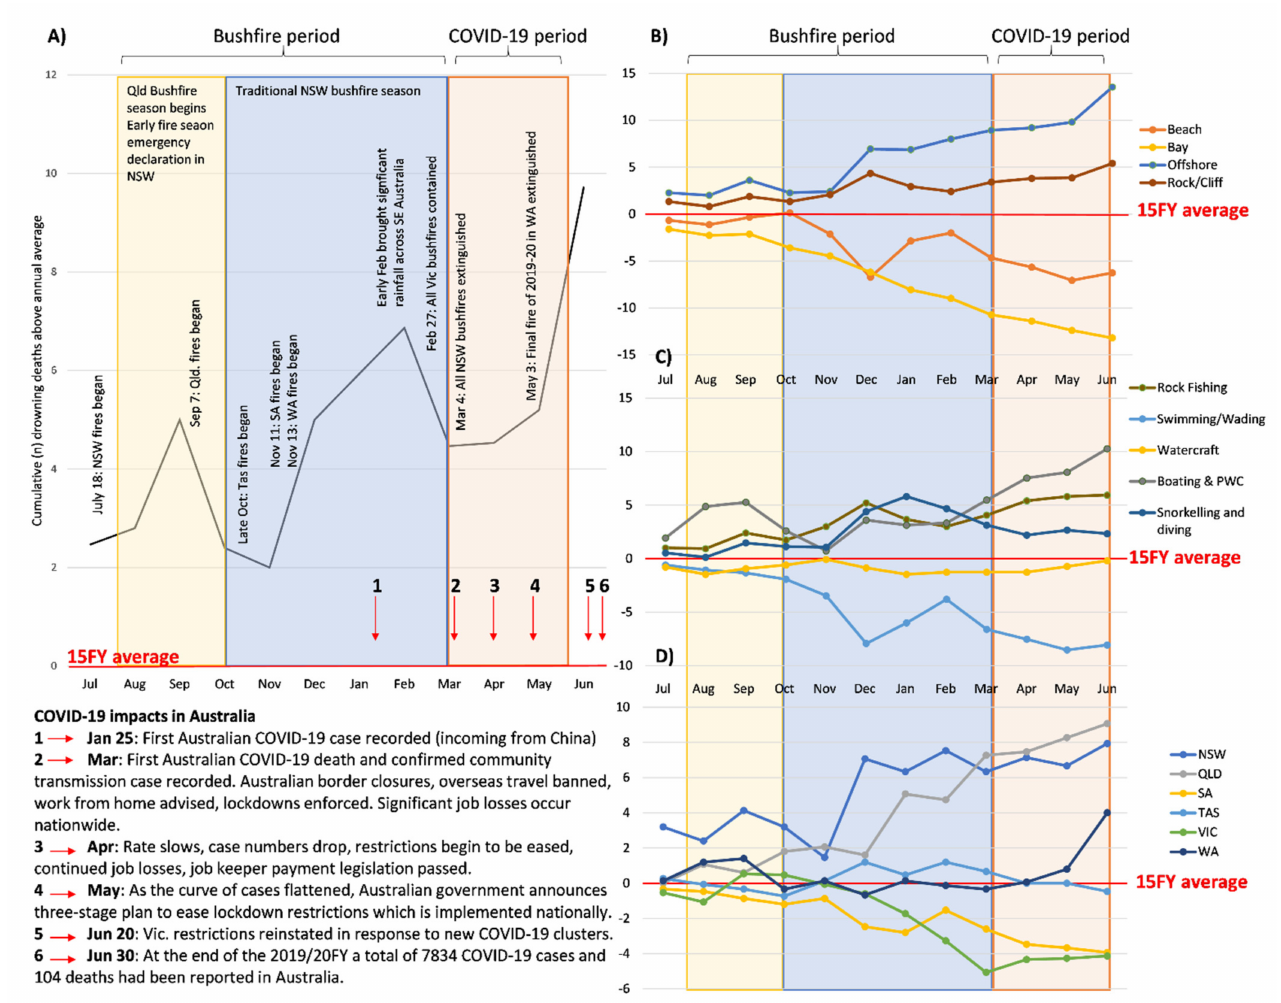
Figure 1. Cumulative differences between 2019/20 financial year compared to the 15-year (15FY) average by ( A ) coastal drowning with important dates relating to the bushfires and the arrival of COVID-19, ( B ) coastal location type, ( C ) activity, and ( D ) state. Shading represents significant time periods of